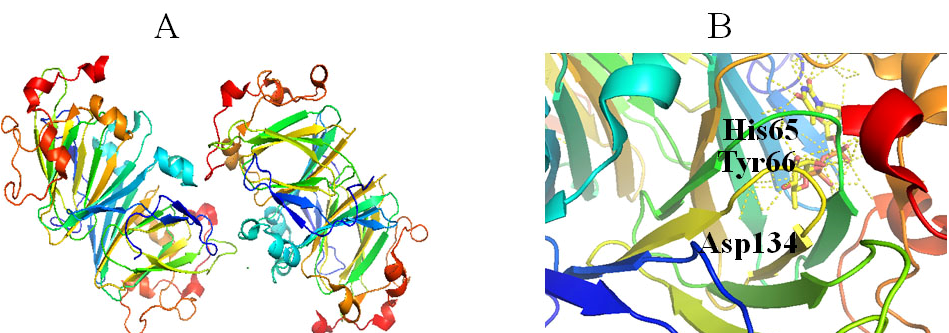
Figure 5. Stereo view of the RmlC (PDB entry 2IXL) ( A ) and His-Asp dyad of RmlC (PDB entry 2IXT) ( B ). Helix, sheet, and loop of RmlC are shown as blue, purple, and beige, respectively. C, N, O, and P elements of ligands are green, blue, red, and brown, respectively. RmlC is shown in cartoon representation, and ligands are shown as sticks [22].